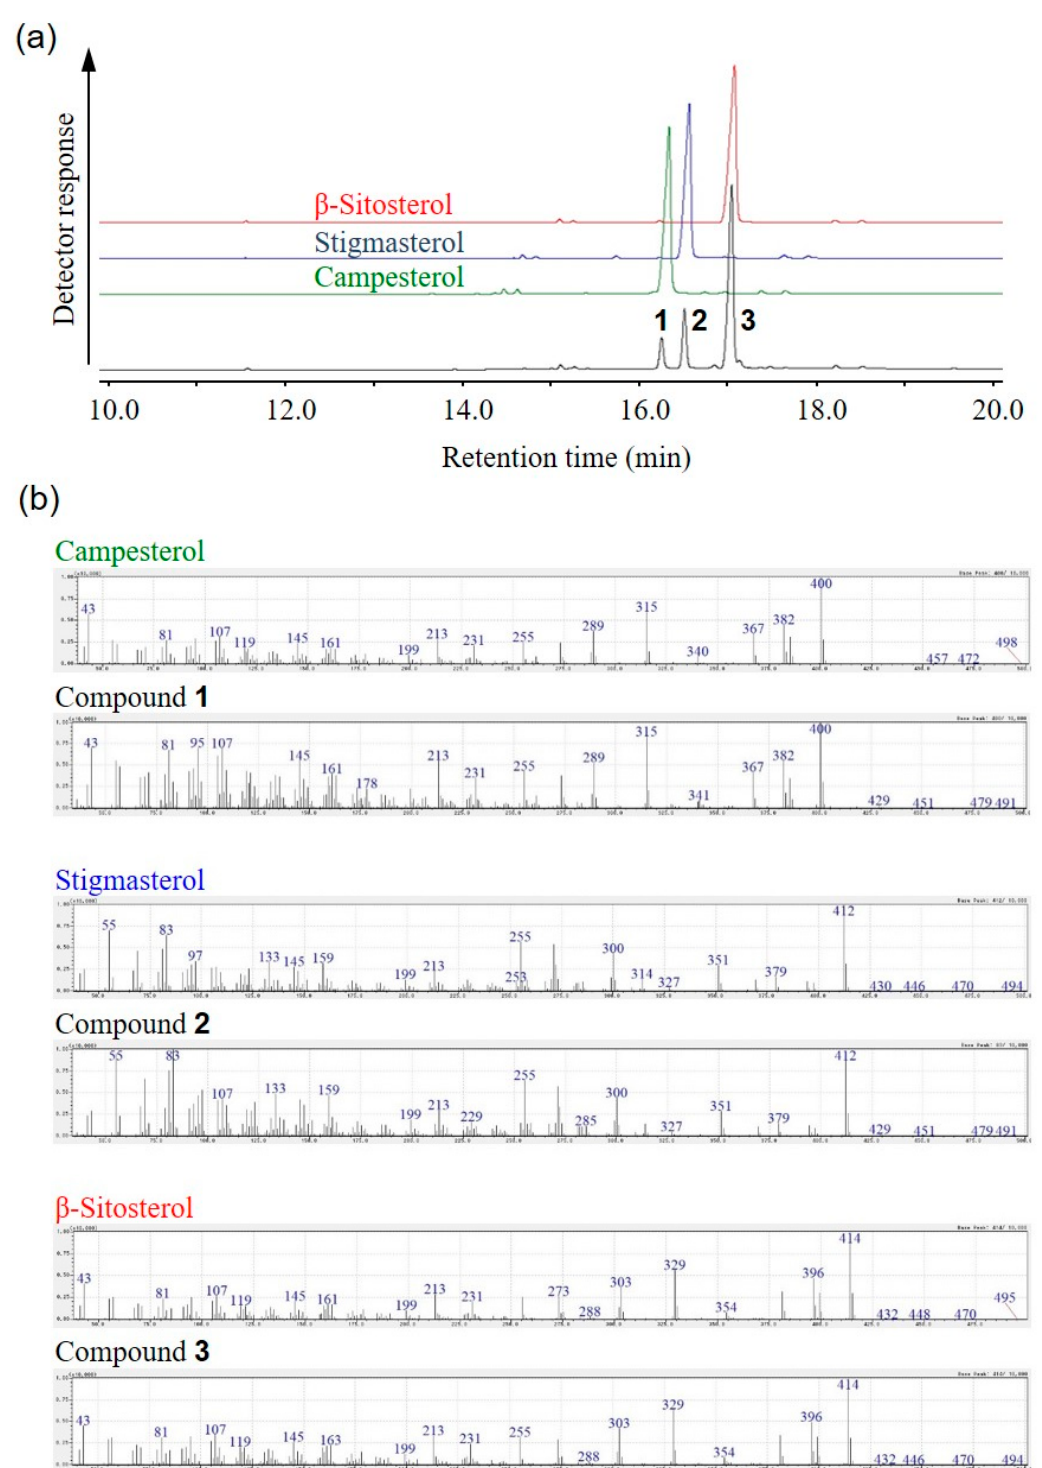
Figure 2. GC-MS chromatograms of the purified fraction and standards of campesterol, stigmasterol and β -sitosterol. ( a ) Total ion chromatograms of campesterol, stigmasterol, β -sitosterol and purified fraction. ( b ) GC-MS fragment ions of the purified fraction and standards of campesterol, stigmasterol and β -sitosterol.